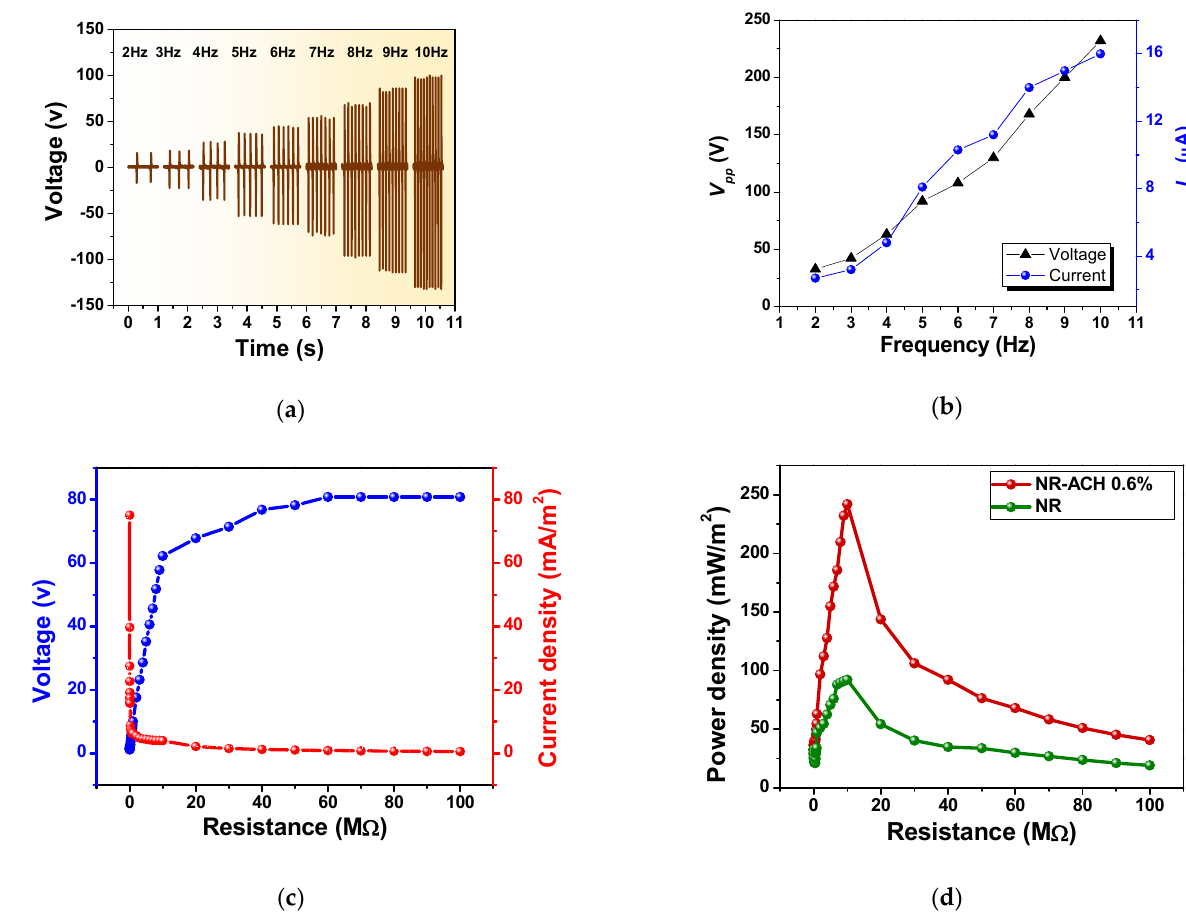
Figure 7. ( a ) Frequency dependence of electrical output voltage and ( b ) the plot of output voltages and currents versus working frequencies ranging from 2–10 Hz of the NR-ACH 0.6% TENG. ( c ) The plot of the measured voltage and current and ( d ) the corresponding power density of the NR-ACH 0.6% TENG when connected at various load resistances.